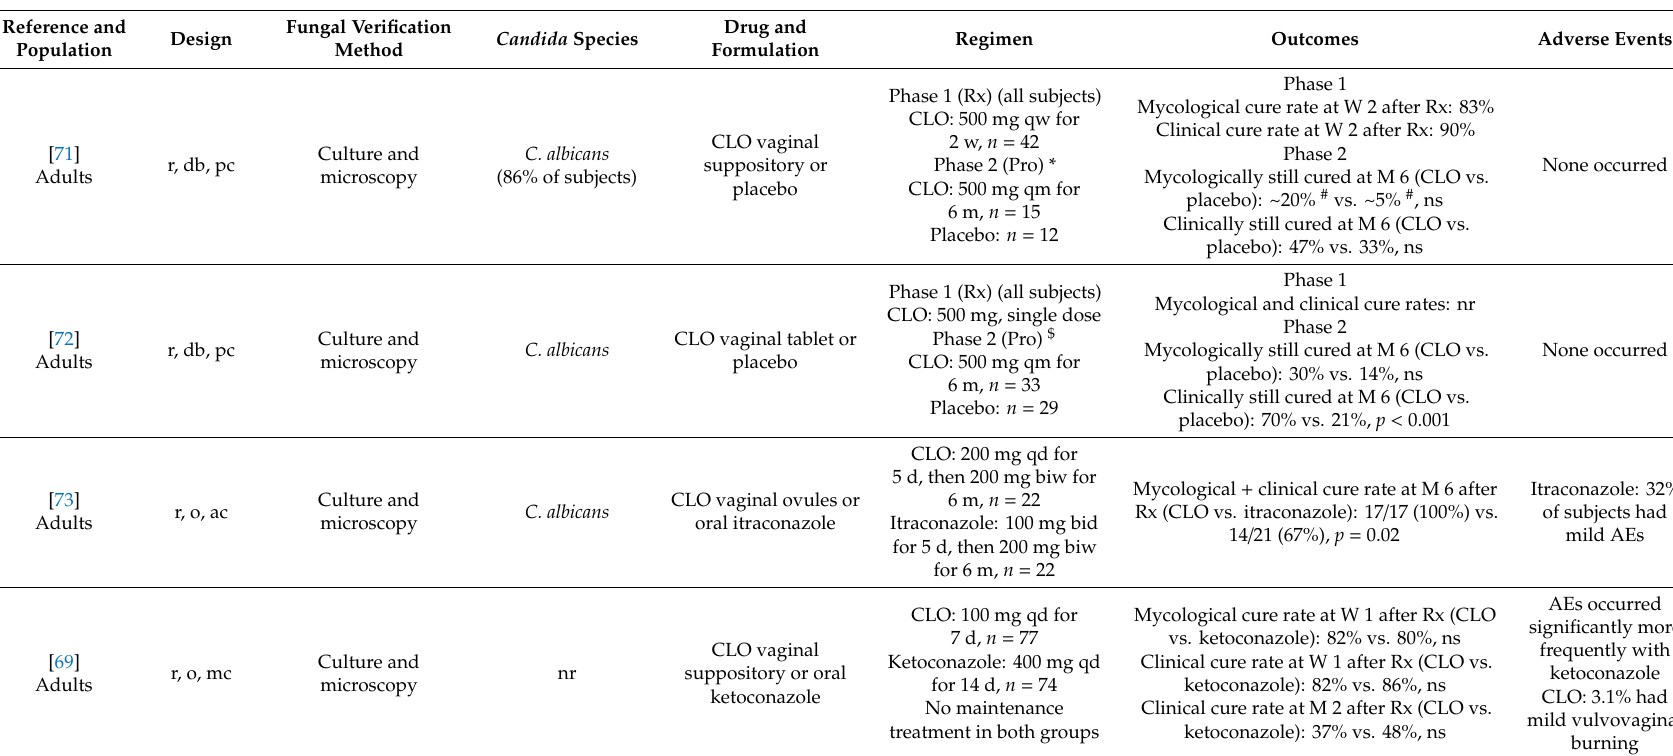
Table 4. Randomized controlled studies investigating intravaginal clotrimazole in women with recurrent symptomatic vulvovaginal candidosis. Reference and